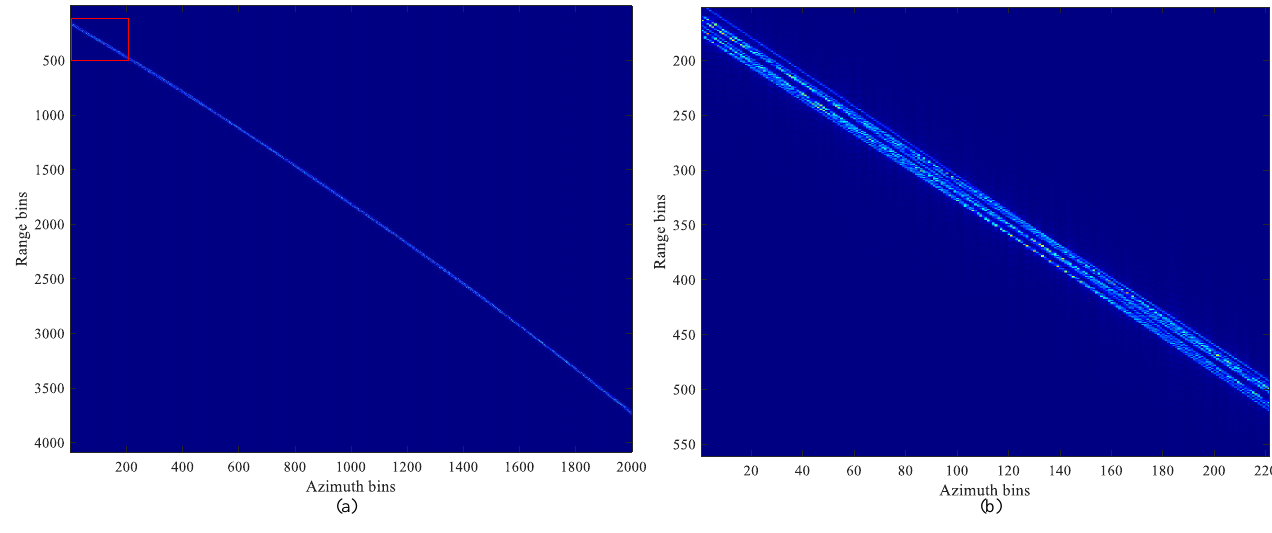
Figure 9. Profile of echo signal after range compression. ( a )Total observed time. ( b ) Local magnifica- tion of ( a